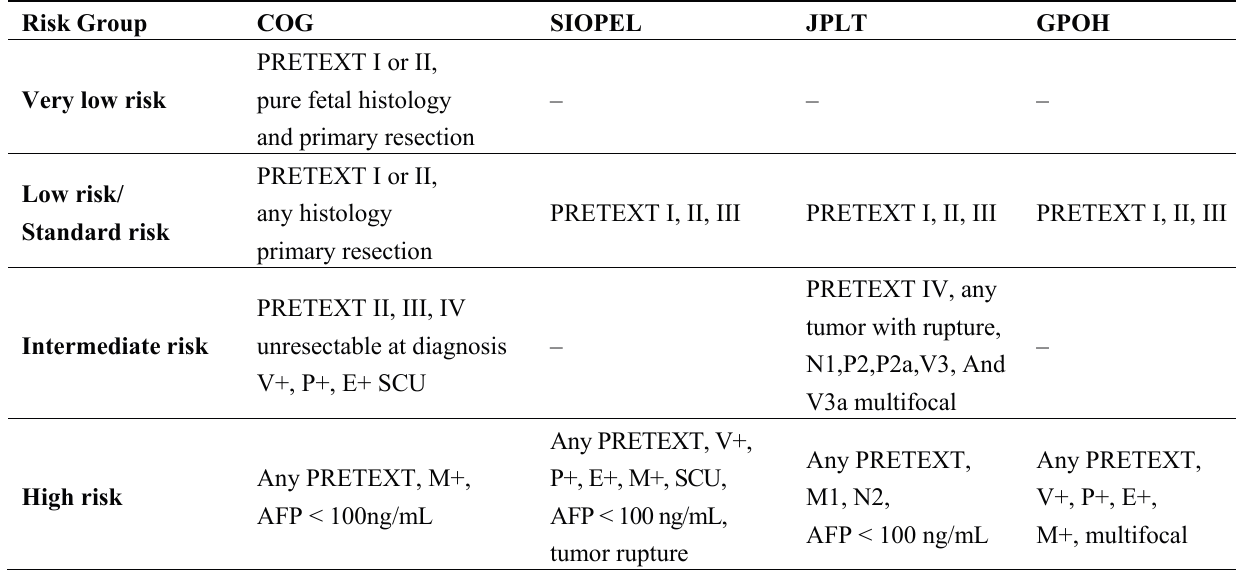
Table 1. International risk stratification [12]. Risk stratification of children with Hepatoblastoma (HB) reflecting the respective international treatment protocols, COG: Children’s Oncology Group; SIOPEL: International Childhood Liver Tumour Strategy Group; JPLT: Japanese Pediatric Liver Tumour Study Group; GPOH: German Society of Pediatric Oncology and Hematology; SCU: small cell undifferentiated; AFP: α -fetoprotein, V (tumor extends into the vena cava and/or all three hepatic veins), P (the main and/or both left and right branch/es of the portal vein are involved by the tumor), E (evidence of extrahepatic intra-abdominal disease), and M (distant